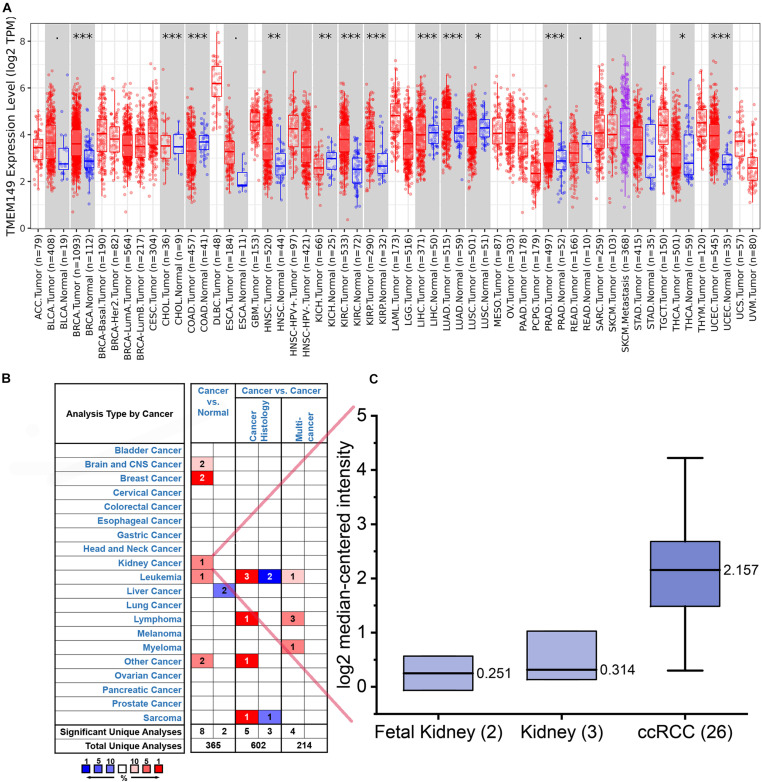
The expression level of IGFLR1 in ccRCC and pan-cancer tissue. (A) The differential expression of IGFLR1 in different cancer and normal tissues using TIMER online platform. The box plot showed the statistical significance of differential expression assessed by Wilcoxon test (n.s.: not significant, *p < 0.05, **p < 0.01, ***p < 0.001). (B) The Oncomine database showed the high or low expression of IGFLR1 in various cancer tissues compared to normal tissues. The threshold in Oncomine is determined according to the following value: p = 0.0001, fold change = 2, rank = top 10%. (NOTE: An analysis may be counted in more than one cancer type). (C) Comparison of IGFLR1 expression levels in normal and tumor tissues of ccRCC.